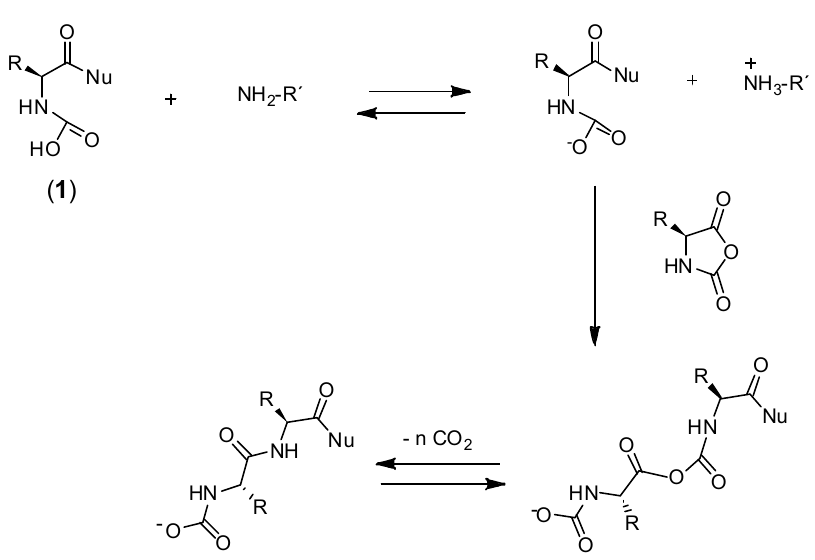
Figure 11. Scheme of the side reaction that usually accompanies the polymerization of NCAs initiated by primary amines commonly called the “carbamate mechanism”.